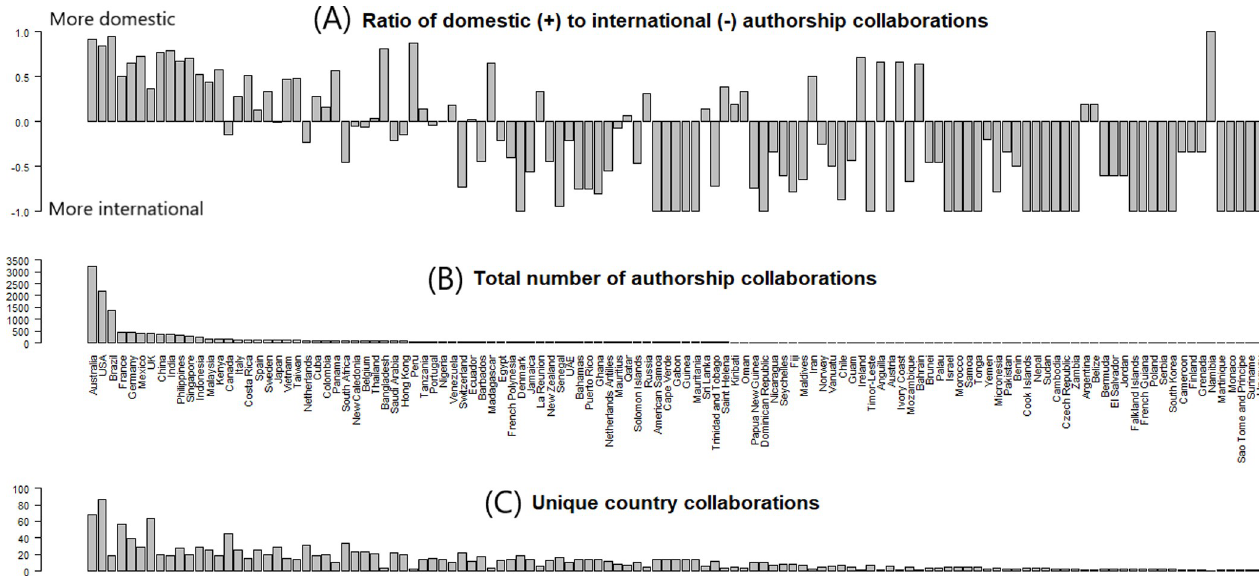
Fig 2. Comparison of co-authorship trends at the country level. (A) Ratio of the number of domestic vs international co-authors per country. (B) Total number of co-authors per country. (C) Number of countries collaborated with (at least once).